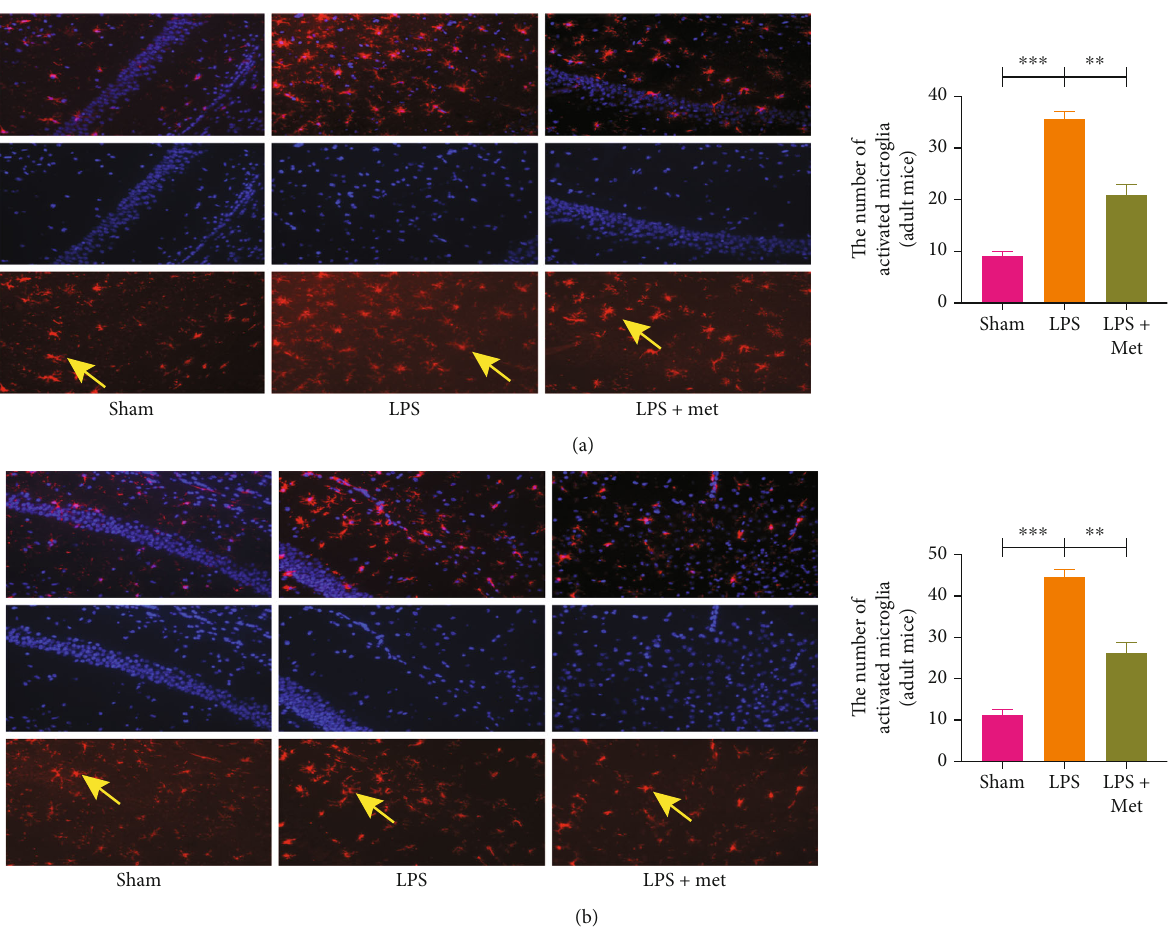
Figure 2: (a) Fluorescent staining of adult mouse microglia. (b) Fluorescent staining of aged mice microglia. As shown in fi gure (a) and (b), microglia were marked with Cy3 red. Activation of microglia in the metformin-treated group was signi fi cantly reduced compared with that in the LPS group. As shown by the arrow: activated microglia. In fi gure (a) and (b), they are shown from top to bottom: the above is the synthesis of the middle and lower fi gures, and the middle fi gure: the nuclei are dyed blue by DAPI method; below: microglia IBA-1, shown in red. ∗ p < 0 : 05 , ∗∗ p < 0 : 01 , ∗∗∗ p < 0 : 001 . n = 10 in each